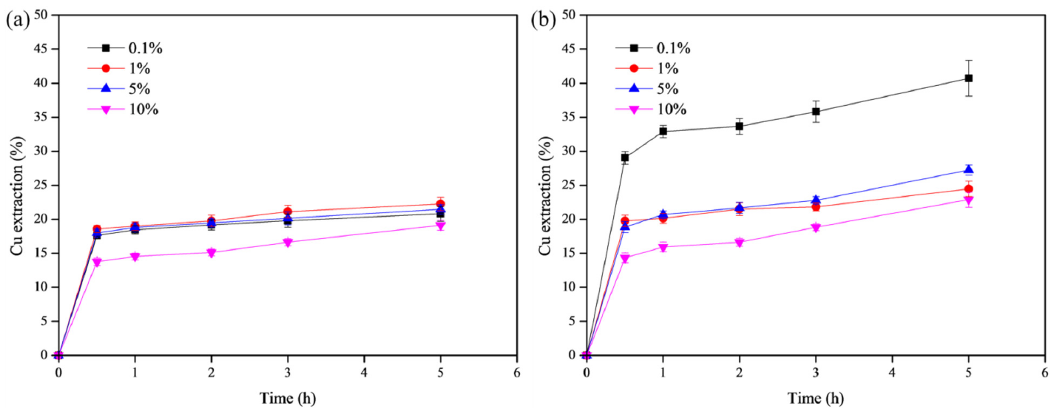
Figure 6. Copper extraction versus leaching time at four solid / liquid ratios ( a ) without and ( b ) with ultrasound assistance at 20% power amplitude (leaching conditions: 0.5 M sulfuric acid concentration, 50 °C, and 800 rpm stirring speed).